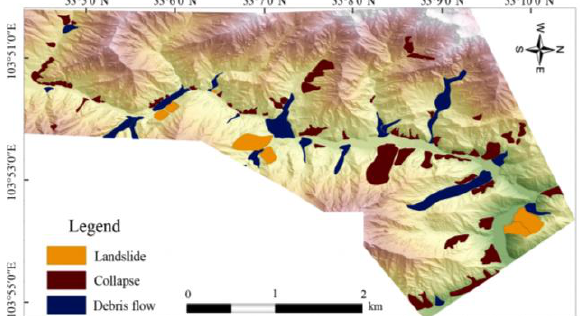
Figure 7. Interpretation of typical debris flow under DEM by airborne LiDAR